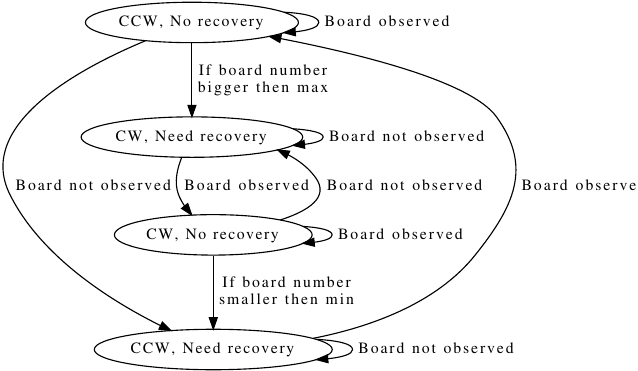
Figure 2. State to state algorithm of camera